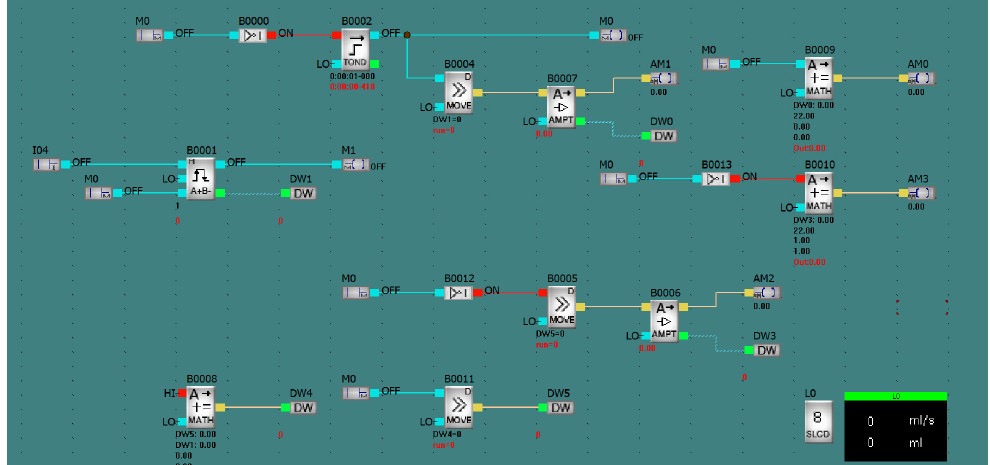
Figure 5. Embedded algorithm simulation.